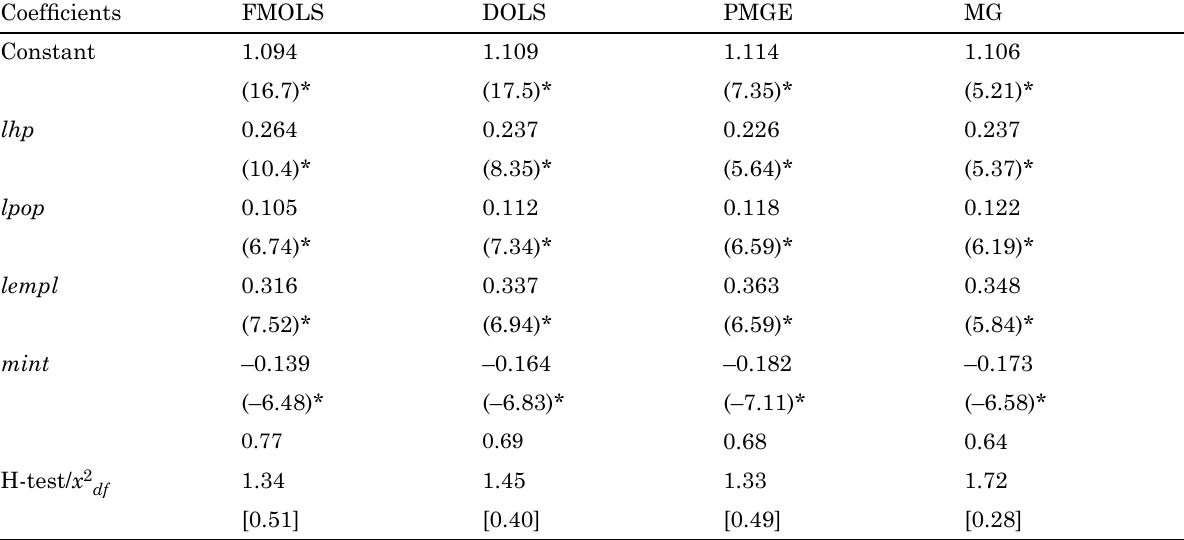
Table B4. Long-run estimates ( lypc is the dependent